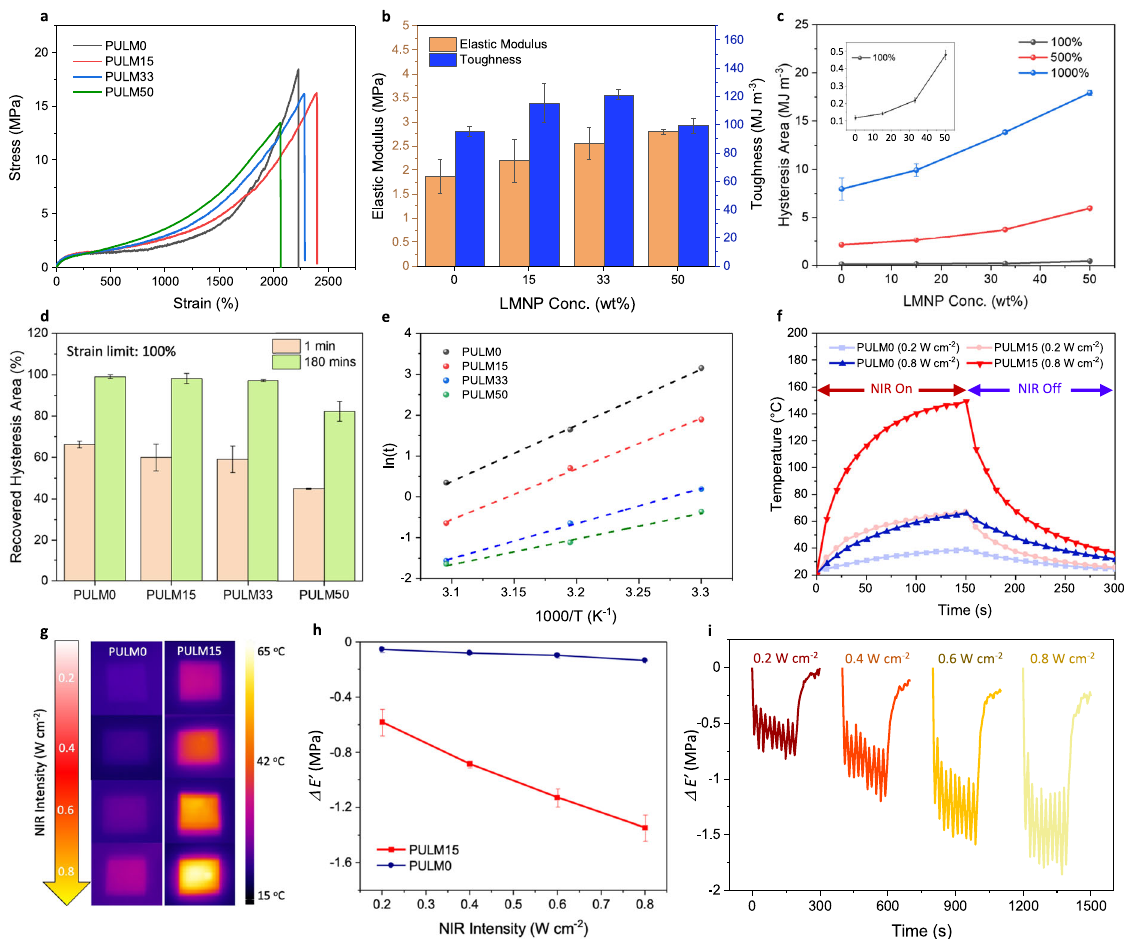
Fig. 2 | Mechanical, photothermal and photomechanical properties of PULM nanocomposites. a Tensile stress strain curve of PULM nanocomposites under a strain rate of 100mmmin − 1 . b Elastic modulus and mechanical toughness of PULM nanocomposites. c Hysteresisarea when PULMnanocomposites arepulled to 100, 500, and 1000% strain after the fi rst cycle of cyclic stress – strain measurements. Insetshowsthehysteresisareaat100%strain. d RecoveredhysteresisareaofPULM nanocomposite cyclic stress – strain curves after a 1min and 180min delay at 100% strain. e Arrhenius fi ttings(dashedlines)ofln(t)versusscaledinversetemperature. t refers to the relaxation time. Slope of Arrhenius fi ttings represents the relaxation